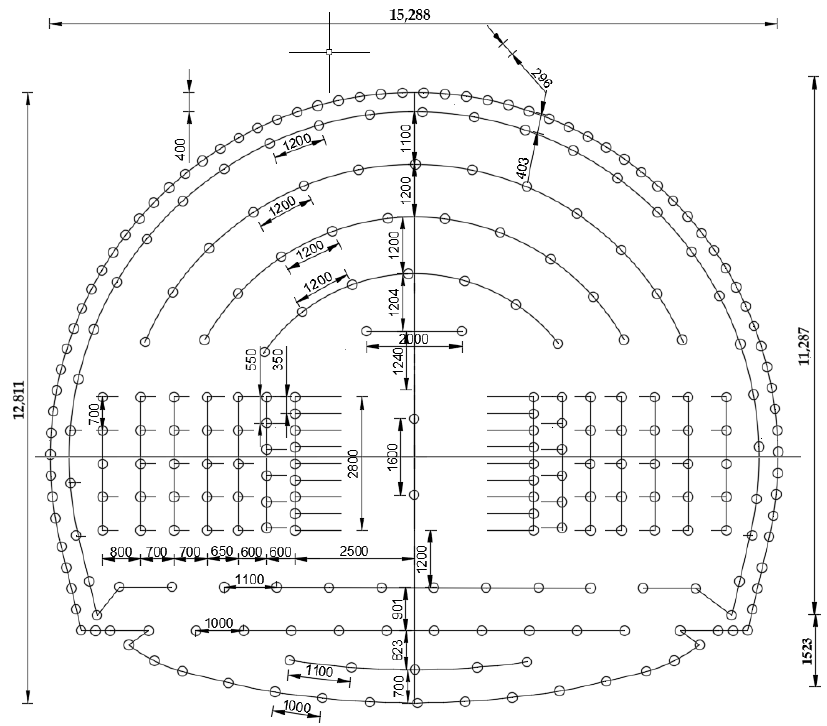
Figure 5. The typical layout of the blasting hole (mm).